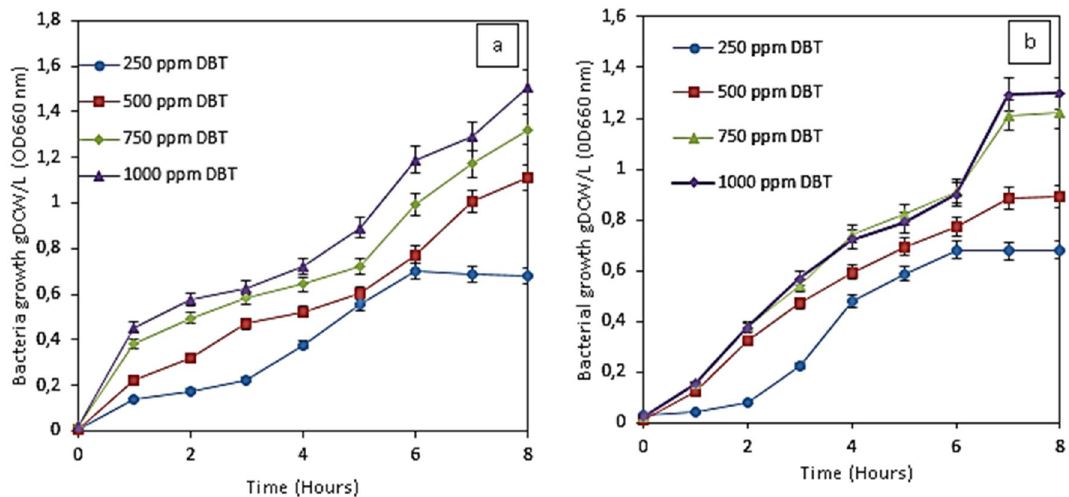
Figure 5. Effect of initial DBT concentrations on the growth of ( a ) Pseudomonas aeruginosa ( b ) Pseudomonas putida at 1:4 oil: water ratio for biphasic. Experimental conditions: Temperature 37 °C ( Pseudomonas aeruginosa ), 30 °C ( Pseudomonas putida ), Shaking speed 130 rpm.